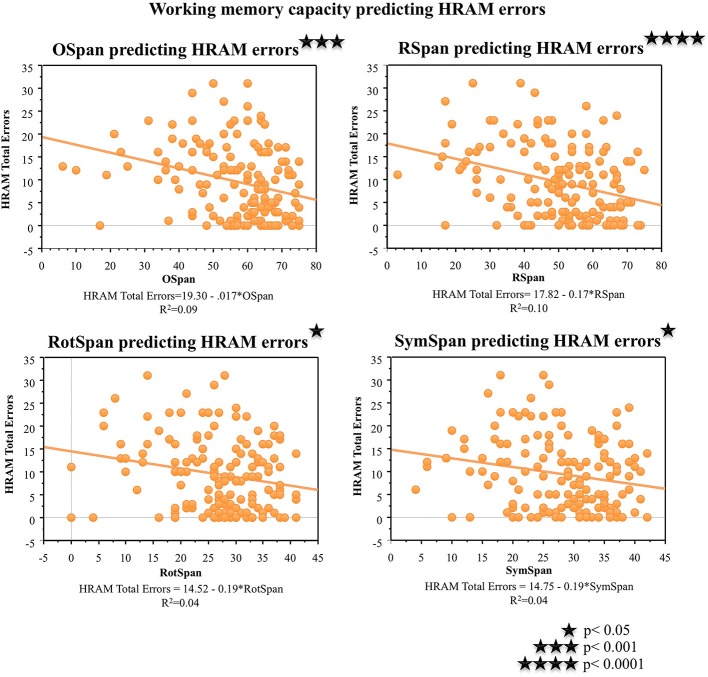
HRAM scores as predicted by working memory measures. Regression analysis indicated that Ospan [F(1, 149) = 14.46, p < 0.001], RSpan [F(1, 149) = 16.65, p < 0.0001], RotSpan [F(1, 149) = 6.62, p < 0.05], and SymSpan [F(1, 149) = 6.44, p < 0.05] performance predicted HRAM Total Errors.